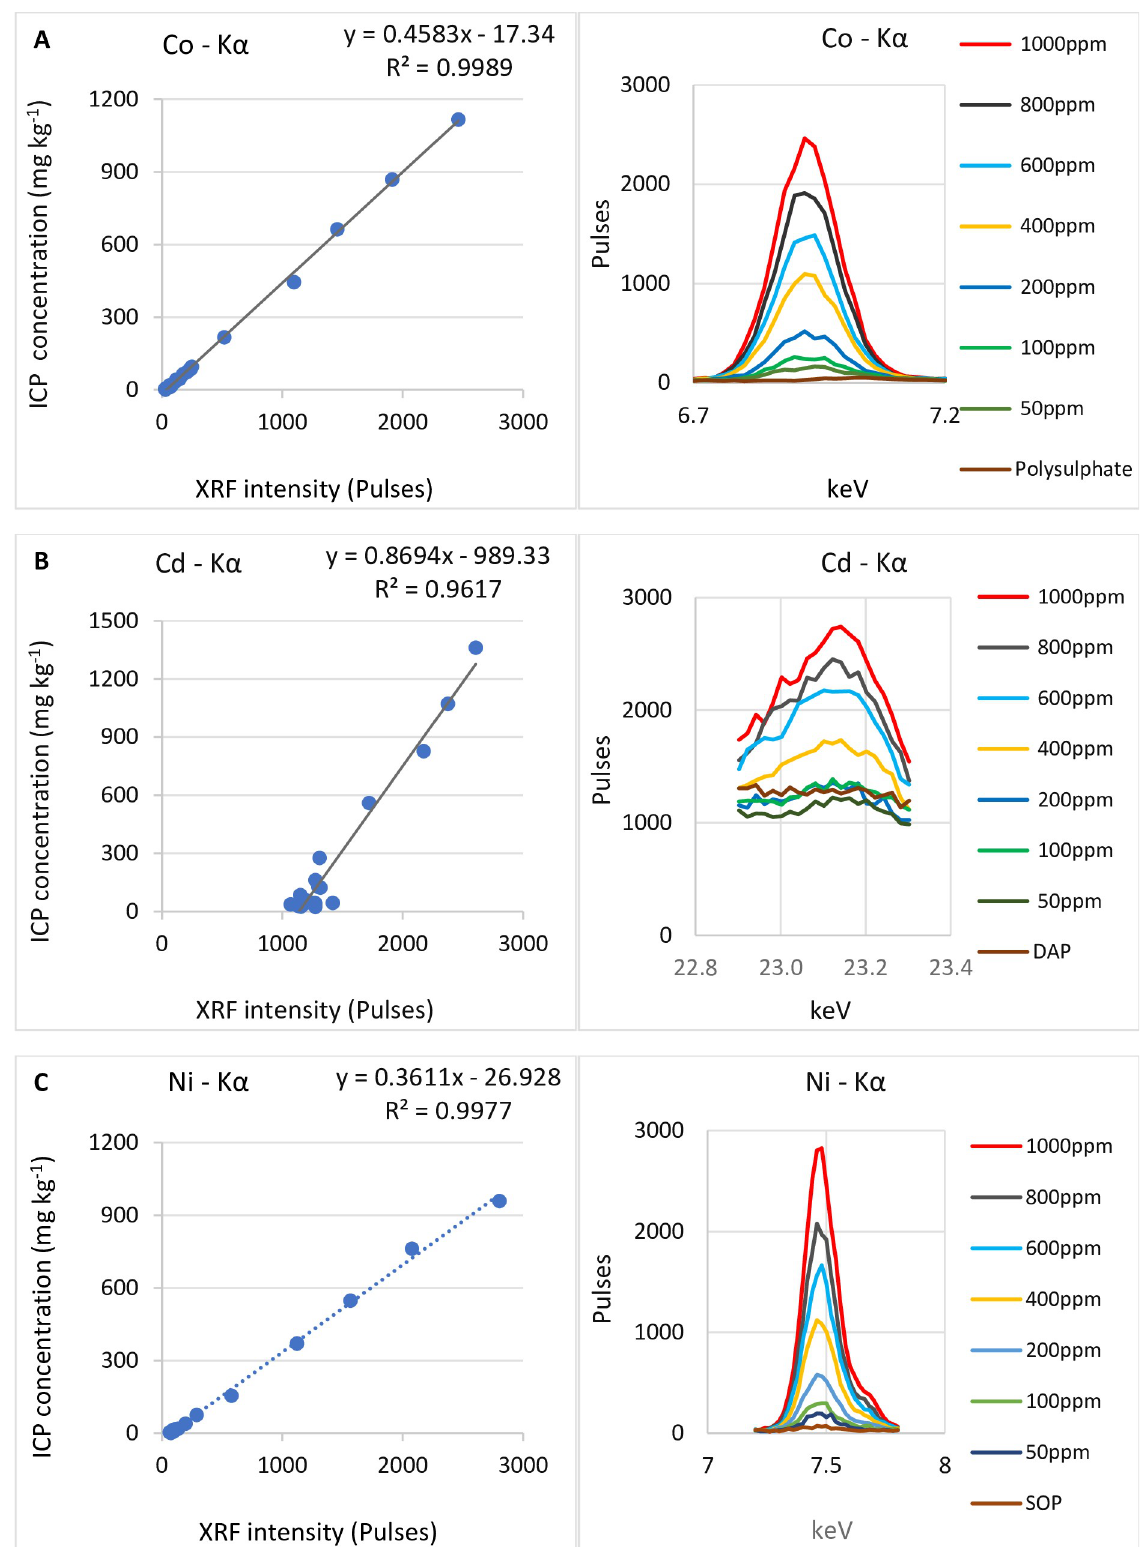
Fig 2. Plots of XRF pulses versus elemental concentrations up to 1000 mg kg -1 . A–Co in Polysulphate; B–Cd in DAP; C–Ni in SOP.